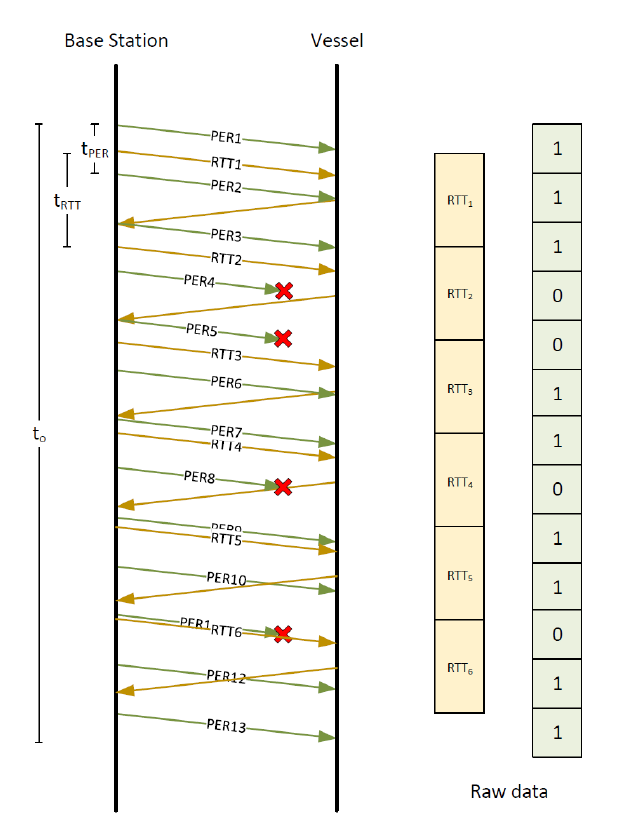
Figure 7. Raw data collecting